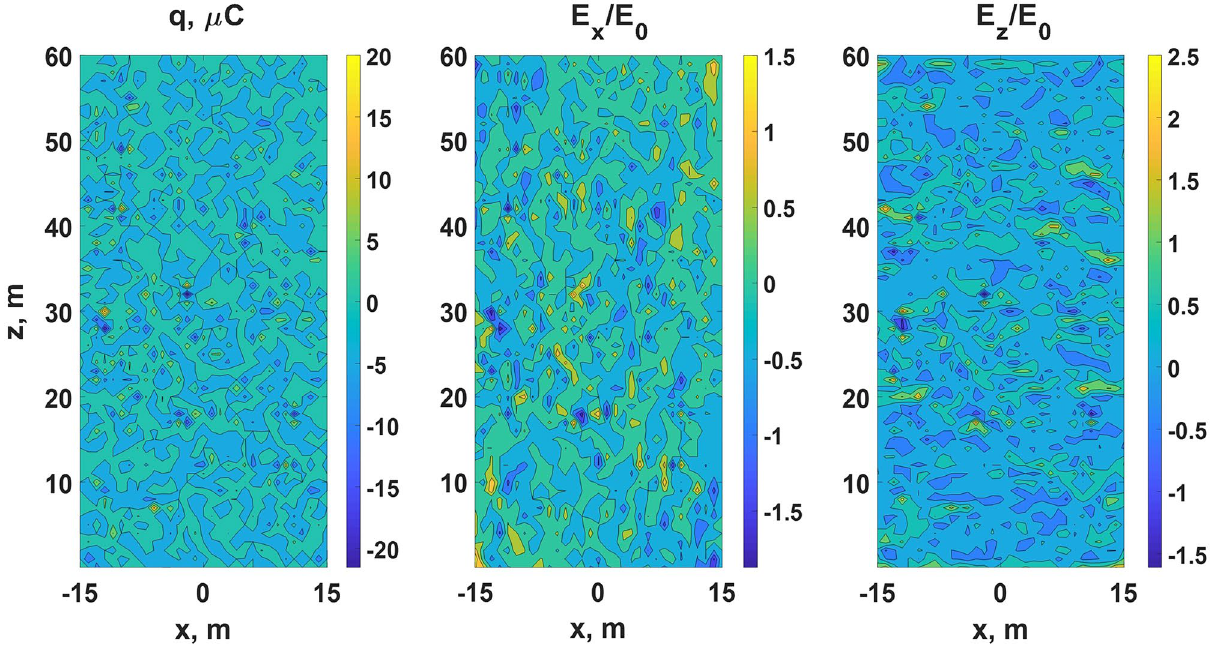
Figure 9. A snapshot of space charge (the left panel) and normalized E x and E z electric field projections (the middle and the right panels, respectively) distributions in the x - z plane at the final moment of discrete time at E 0 e − 1 obtained for the field-independent case under p which E eff ≈ clusters (polarized EICRs), concentrating positive and negative charges at their tips, provides space